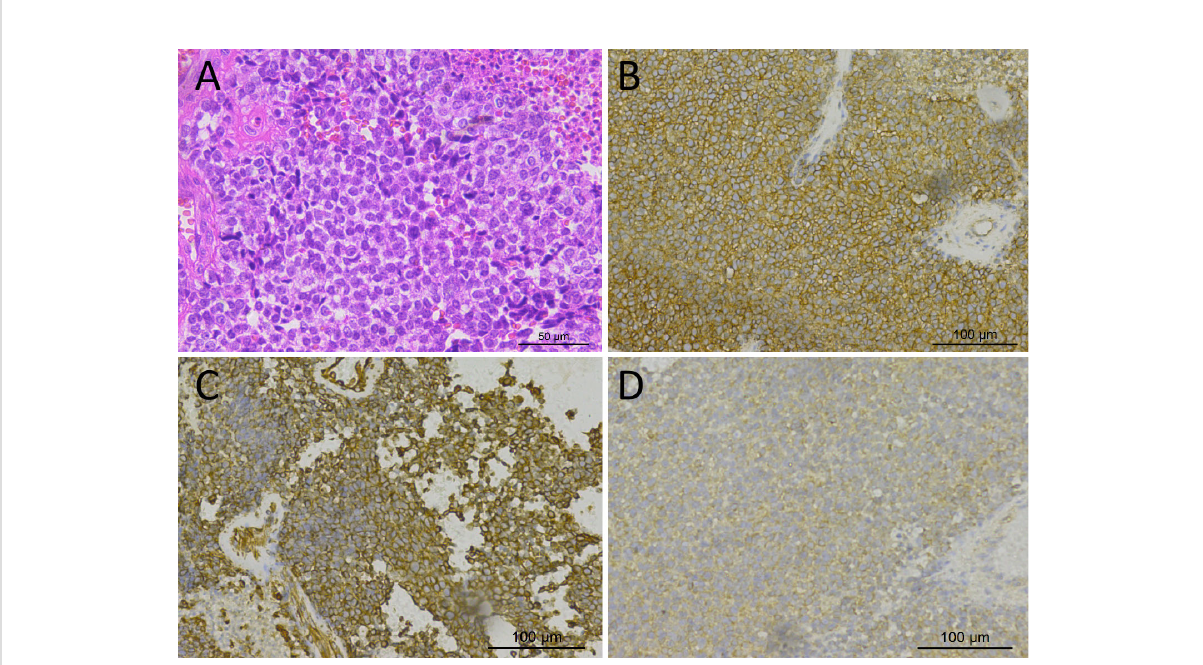
FIGURE 2 Hematoxylin – eosin staining showed that the tumor tissue was composed of small round cells with relatively uniform morphology, and the nuclei were deeply stained (A) . Immunohistochemical staining showed that tumor cells positively expressed CD99 (B) , Vimentin (C) , and Bcl-2 (D)